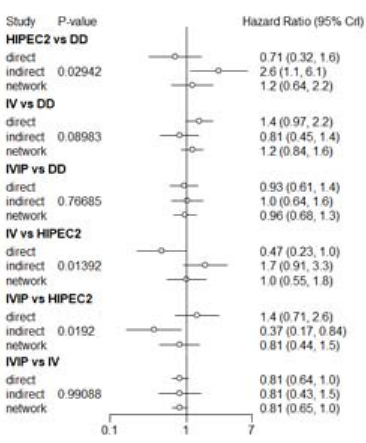
Figure A6. Result of node-splitting analysis for PFS.